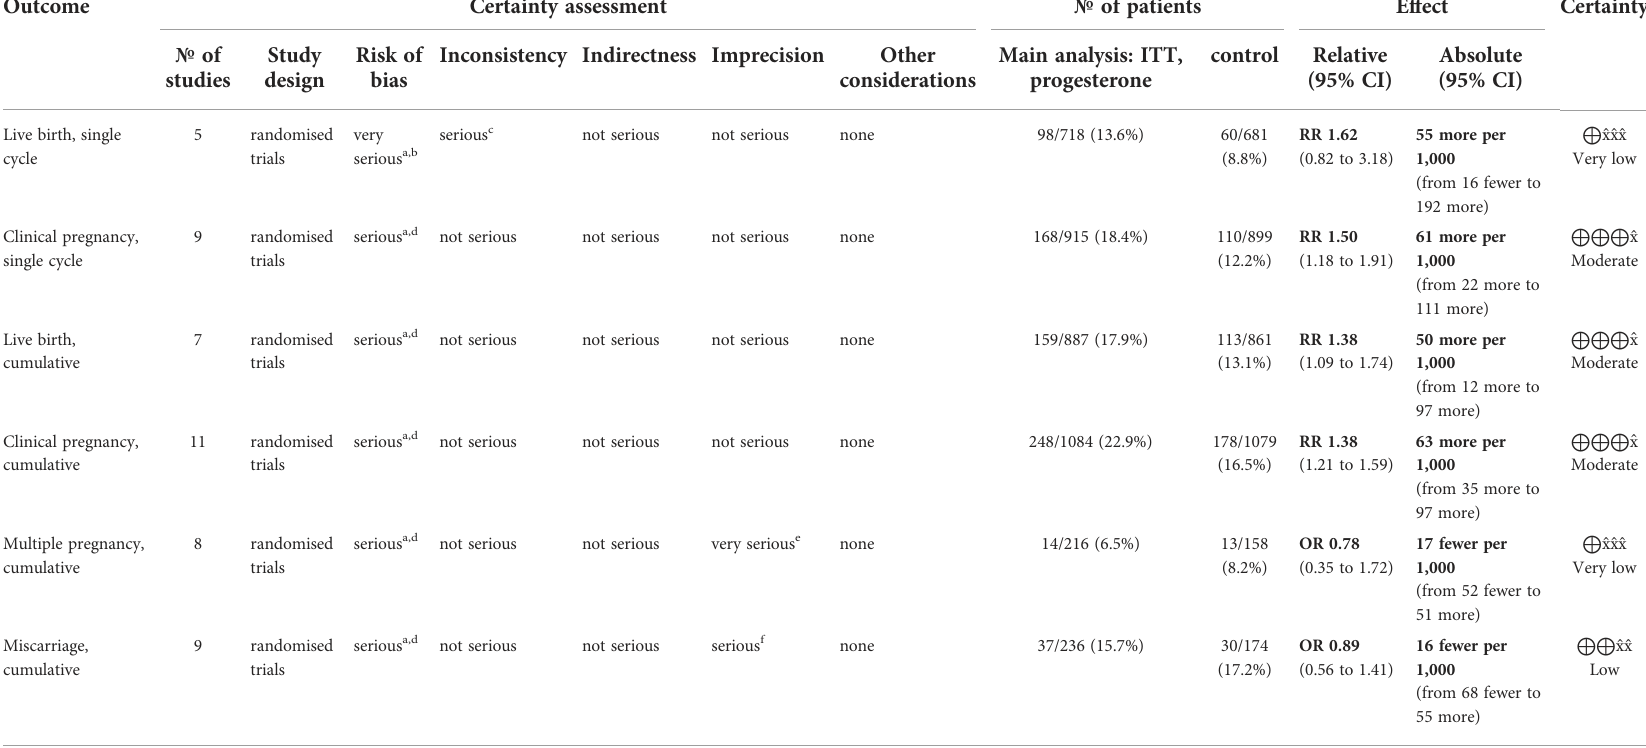
TABLE 3 Summary of